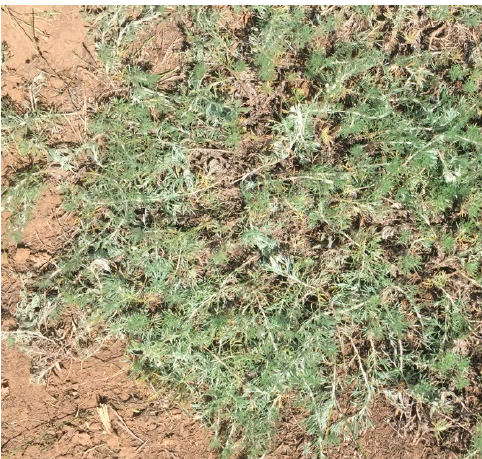
Figure 11. Photo of Artemisia frigida from Bainyinkulun Grassland.